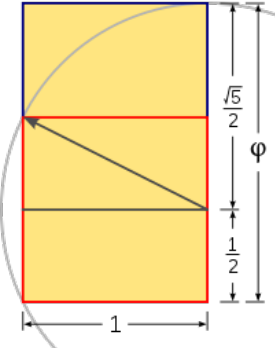
Figure 1: Inner divisions of a Golden rectangle